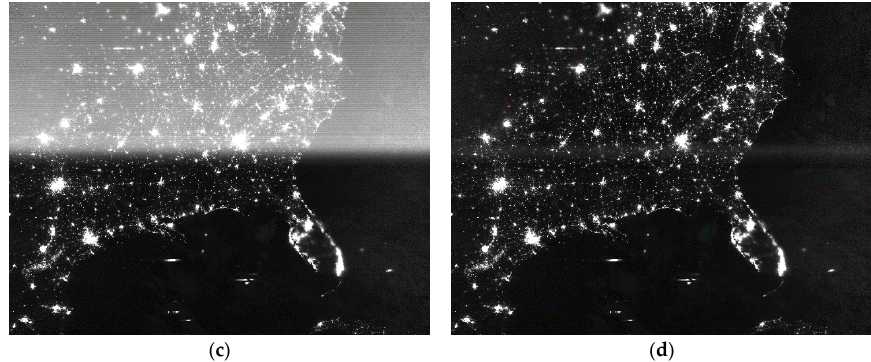
Figure 11. DNB nighttime SDR images over the eastern U.S. on ( a ) 19 June 2012 before the stray light correction; ( b ) 19 June 2012 after the correction; ( c ) 12 June 2015 before the correction and ( d ) 12 June 2015 after the correction.